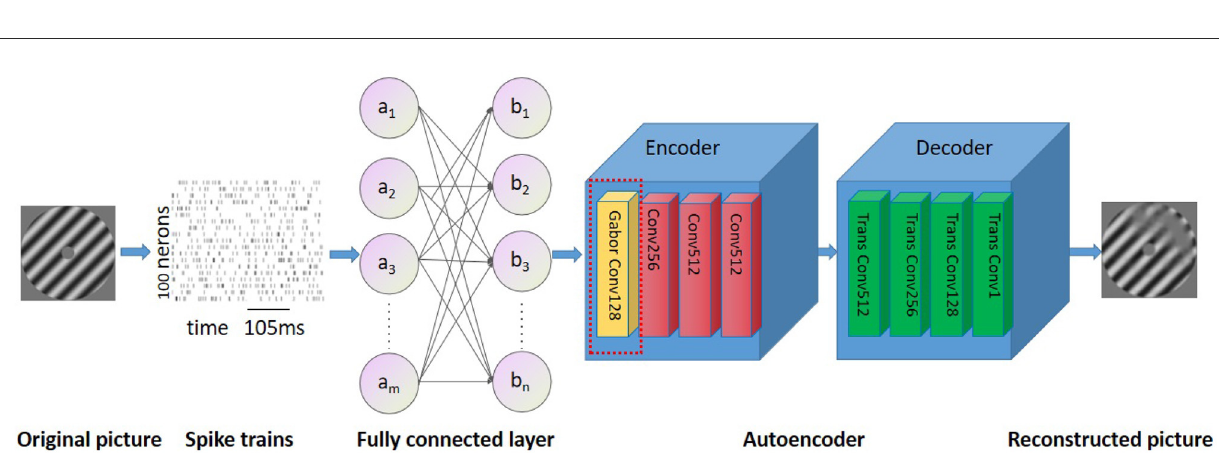
W is a matrix with receptive field properties in Equation (7) and the picture’s size determines the W matrix’s size (Figure